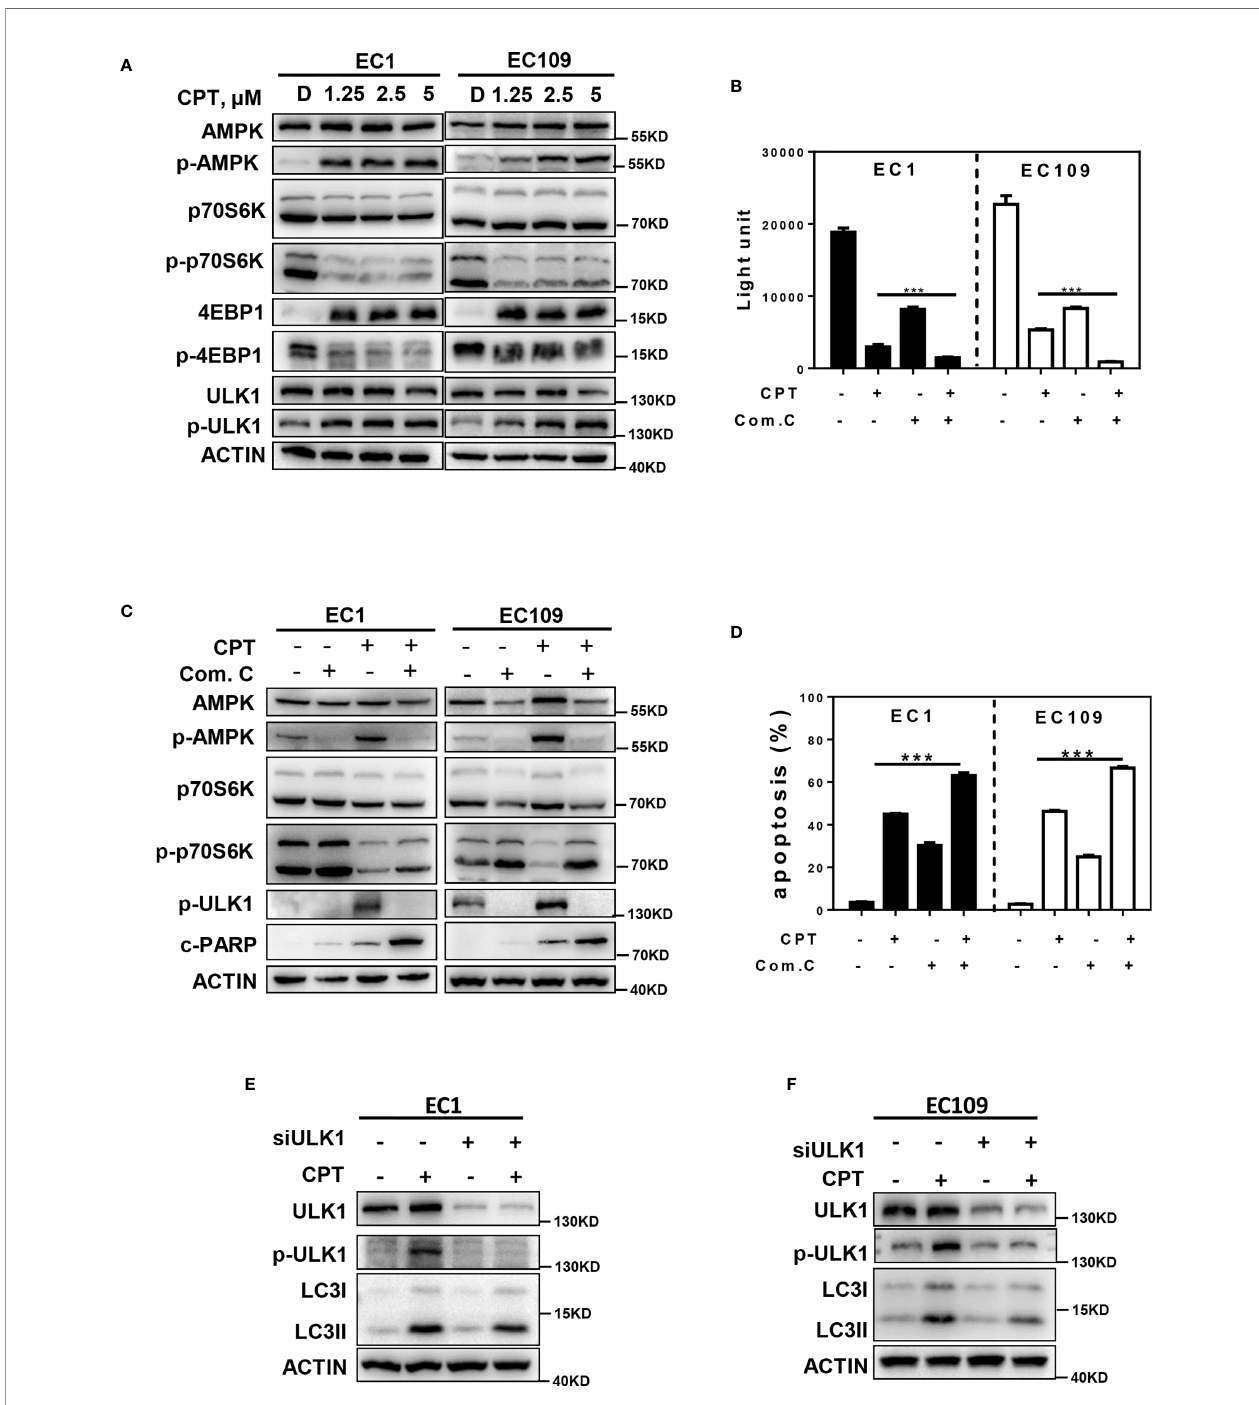
FIGURE 3 | AMPK/mTOR/ULK1 axis contributes to CPT induced autophagy. (A) EC1 and EC109 cells were treated with DMSO and 1.25, 2.5, 5 m mol/L CPT for 24 h and then collected and subjected to IB analysis for the expression of AMPK, p-AMPK, p-70S6K, p-p70S6K, 4EBP1, p-4EBP1, ULK1, and p-ULK1. (B) EC1 and EC109 cells were treated with 2.5 m mol/L CPT alone or CPT + Com.C (5 m mol/L) for 72 h and subjected to ATPLite assay ( n = 3). (C) EC1 and EC109 cells were treated with 2.5 m mol/L CPT alone or CPT + Com.C (5 m mol/L) for 24 h and subjected to IB analysis for the expression of AMPK, p-AMPK, p-ULK1, p70S6K, p-p70S6K, and c-PARP. (D) EC1 and EC109 cells were treated with 2.5 m mol/L CPT alone or CPT + Com.C (5 m mol/L) for 48 h. Apoptosis induction was quanti fi ed by Annexin V-FITC/PI double-staining analysis ( n = 3). (E, F) Autophagy was rescued by ULK1 siRNA silencing. ULK1 knockdown largely abrogated CPT-induced conversion of LC3-I to LC3-II in EC1 and EC109 cells. EC1 and EC109 cells were transfected with control or siULK1 for 48 h and then treated with 2.5 m mol/L CPT for 24 h. Knockdown ef fi ciency and LC3 were assessed by IB analysis. Data were presented as mean ± S.E.M. *** P <